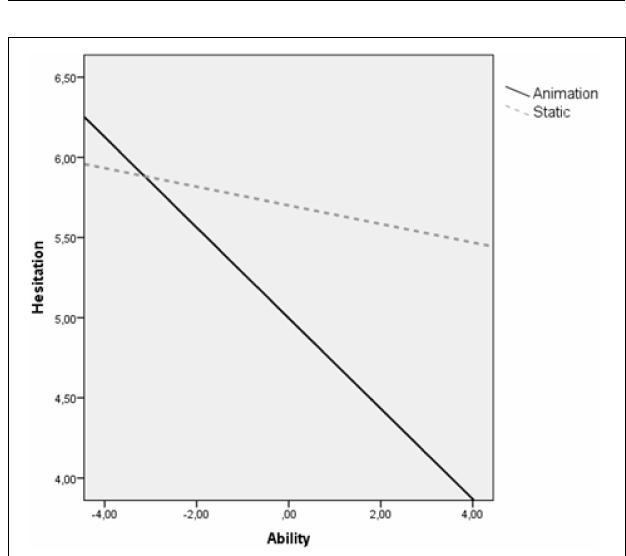
FIGURE 6 | Motor recall performance moderated by spatial ability.